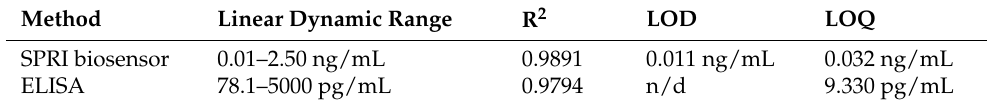
Table 1. Parameters of the calibration curve obtained by the SPRi biosensor and the ELISA method.